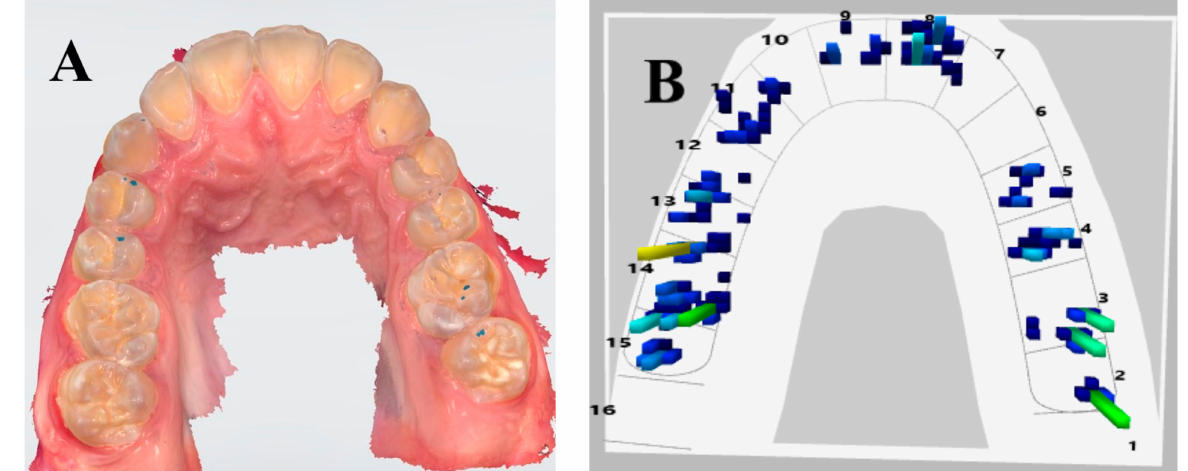
Figure 3. ( A ) Complete contacts according to the Trios system. The system detects contacts in only four points: the mesial surface of the first upper right premolar, the mesial surface of the second upper right premolar, the central area of the first upper left molar, and the mesial surface of the second upper left molar. ( B ) Occlusal diagram according to the T-Scan system. Almost symmetrical contacts exist except for the upper left lateral incisor and canine area.